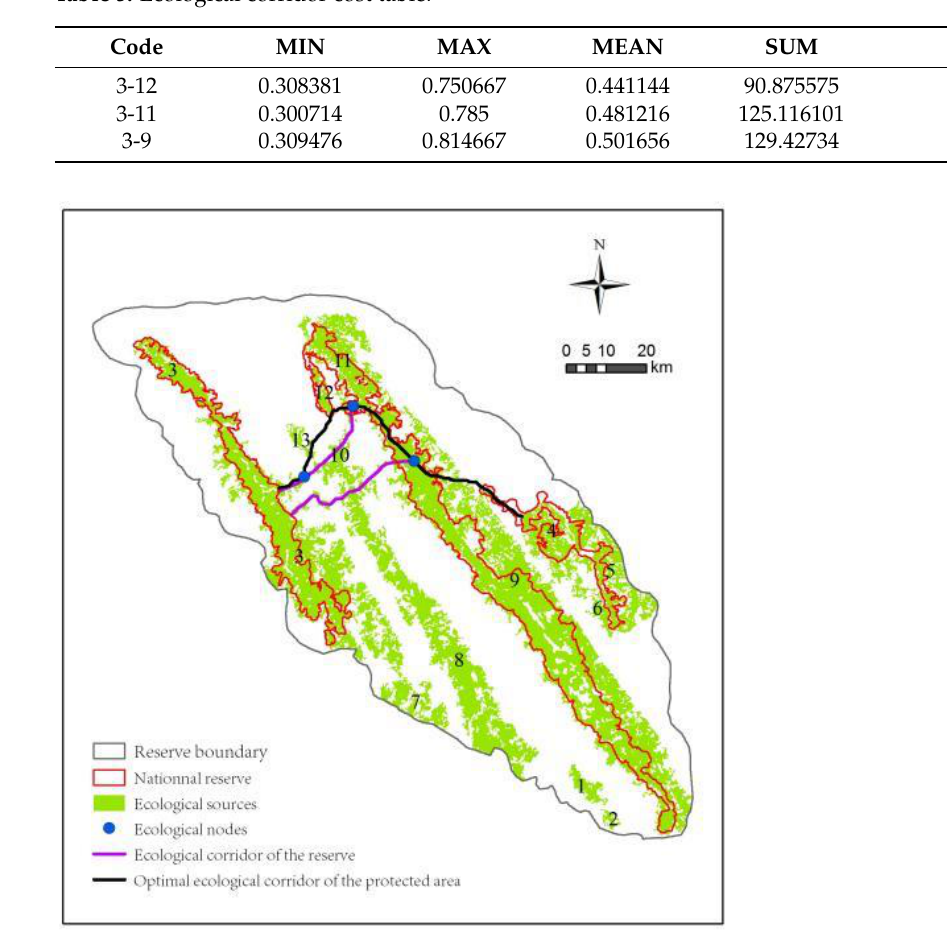
Figure 5. Reserve ecological corridors. Table 5. Ecological corridor cost